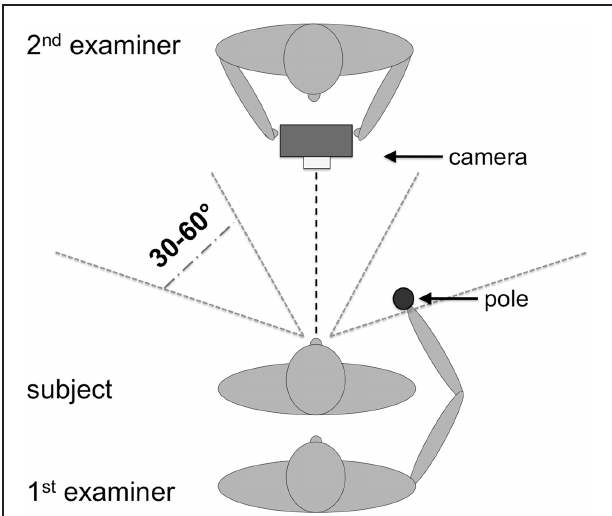
FIGURE 1 | Setup for the OA test procedure. One examiner presented the pole to the participant while the other examiner observed the performance of the participants and controlled eye movements. The height for the target presentation varied between elbow height of the patient (with relaxed arms at the side of the body) and the top of his/her head.